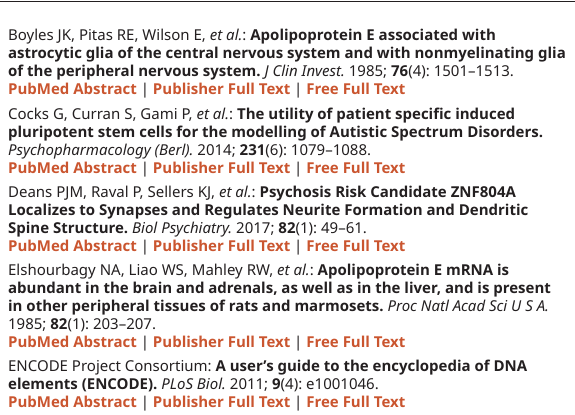
Figshare: raw data for quantification of D12 and D18/19